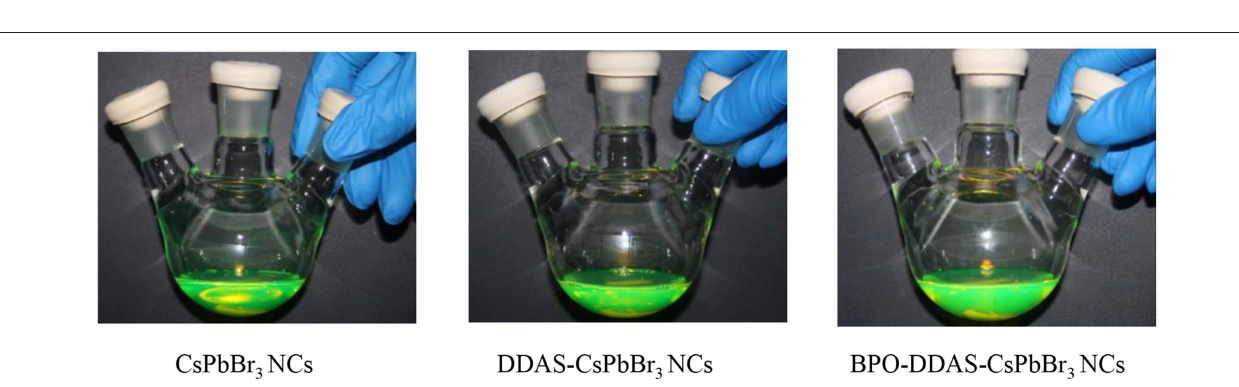
when the BPO was 0.375 mmol, the DDAS-CsPbBr 3 NCs were excessively oxidized; destroying the structure of the NCs, and the solution showed a pale yellow color and became turbid ( Figure 5